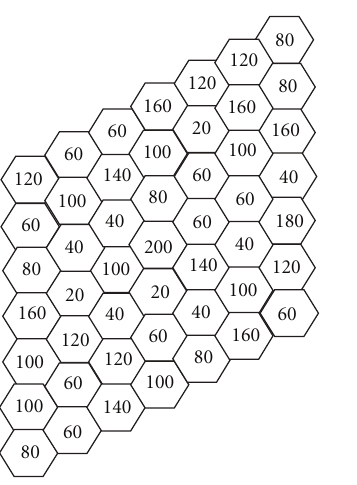
Figure 5: Non uniform tra ffi c distribution pattern.